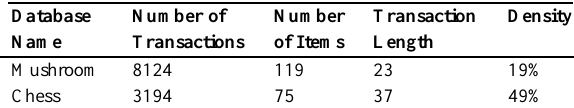
Table 9. Characteristics of databases.